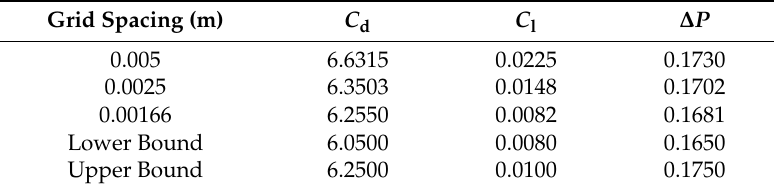
Table 2. Fluid characteristic quantities for steady state laminar flow over a cylinder. Simulation results are listed for three different grid sizes. Lower and upper bounds present the estimated interval for the exact results [48].